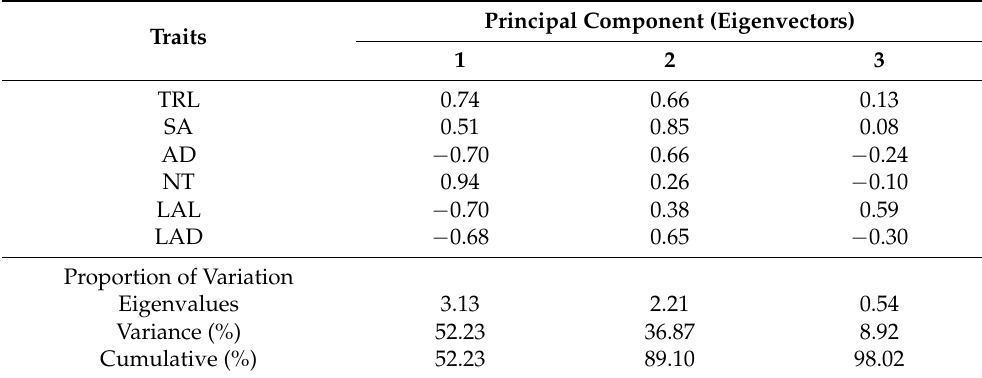
Table 4. Variable loading score of six root traits and variance proportion for each principal component. Traits